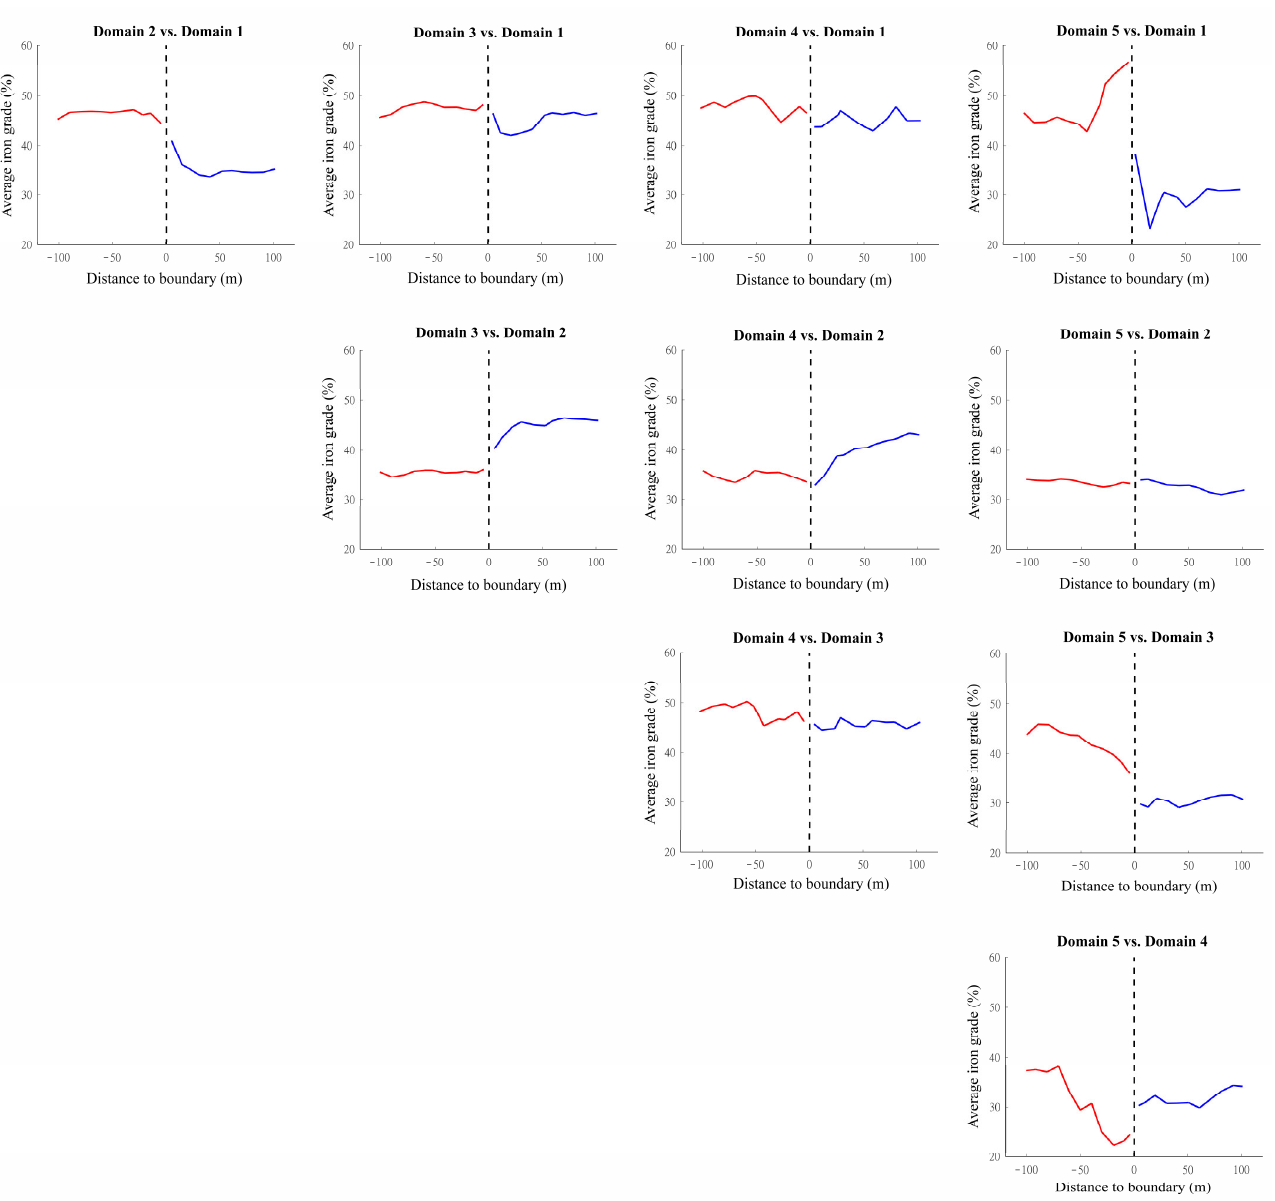
Figure 4. Average iron grade as a function of the signed distance to the domain boundaries. The red and blue curves represent the average grade in two different geological domains, and the dashed line stands for the boundaries between both domains.